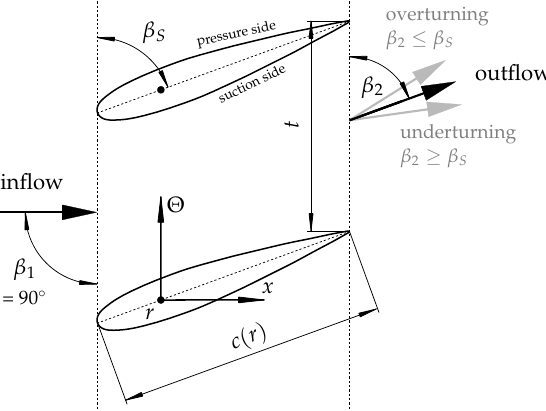
Figure 2. Scheme of the cascade in a plane of constant radius.